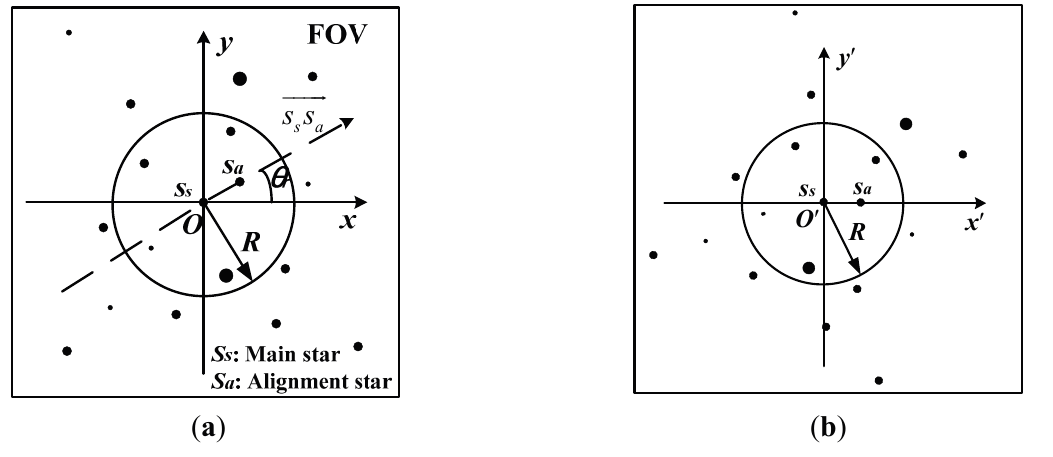
Figure 2. The vector direction of the star pattern. ( a ) The alignment star; ( b ) The stellar image is